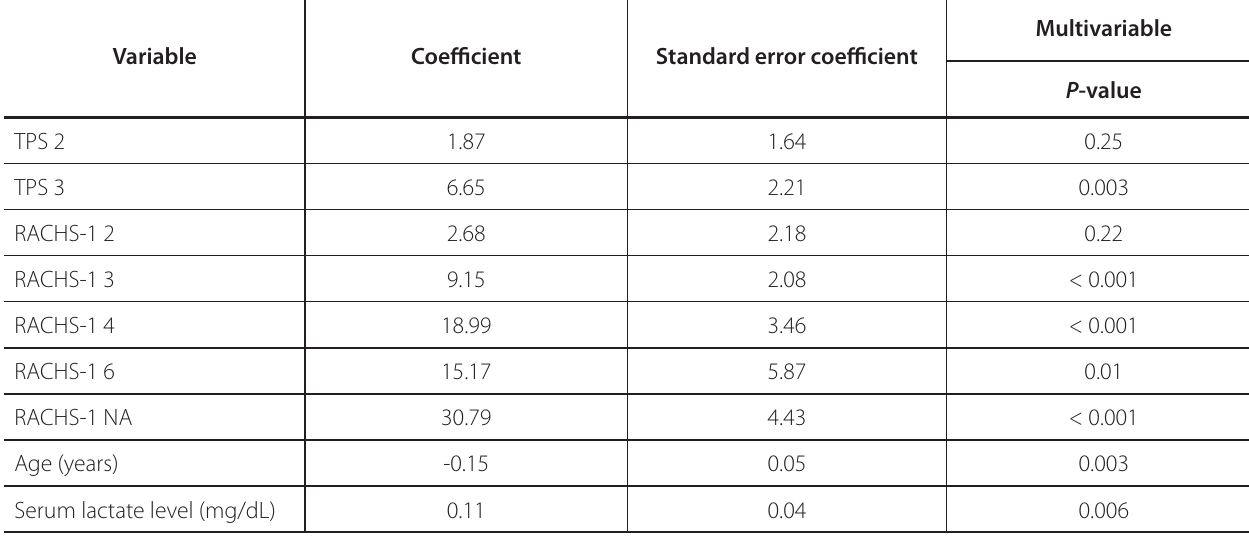
Table 6 . Postoperative length of stay risk factors — multivariable